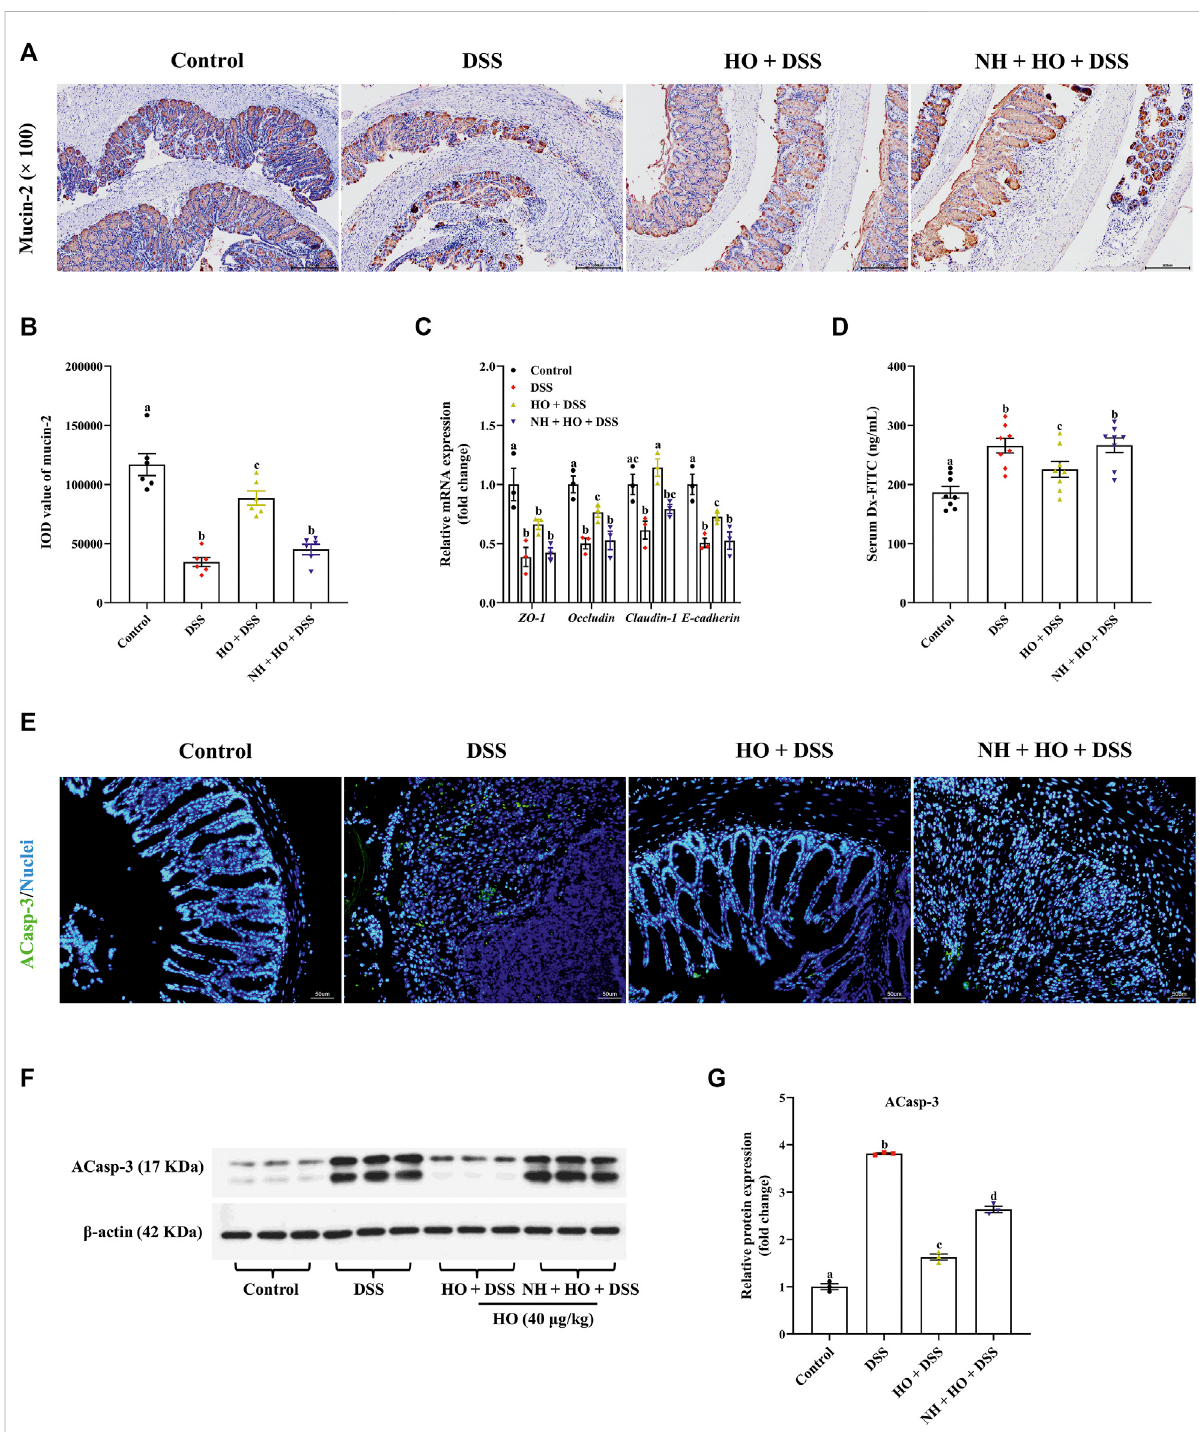
FIGURE 5 HO treatment improves intestinal barrier function in DSS-exposed mice through the opioid pathway. (A) Immunohistochemical staining with mucin-2 and E-cadherin in colonic sections. (B) Quantitative integrated optical density (IOD) analysis of colonic mucin-2. (C) Relative gene expression of tight junction proteins in the colon. (D) Serum Dx-FITC level. The data are expressed as mean ± S.E.M. ( n = 3 – 8). (E) Apoptosis in the colonic mucosa of each group of mice. Green indicates the presence of ACasp-3, and Nuclei are blue. (F) Western blot analysis of ACasp-3 expression in the colon. (G) Quantitative analysis of the relative contents of ACasp-3. Bars with different letters represent signi fi cant differences between groups by Fish ’ s LSD test ( p <